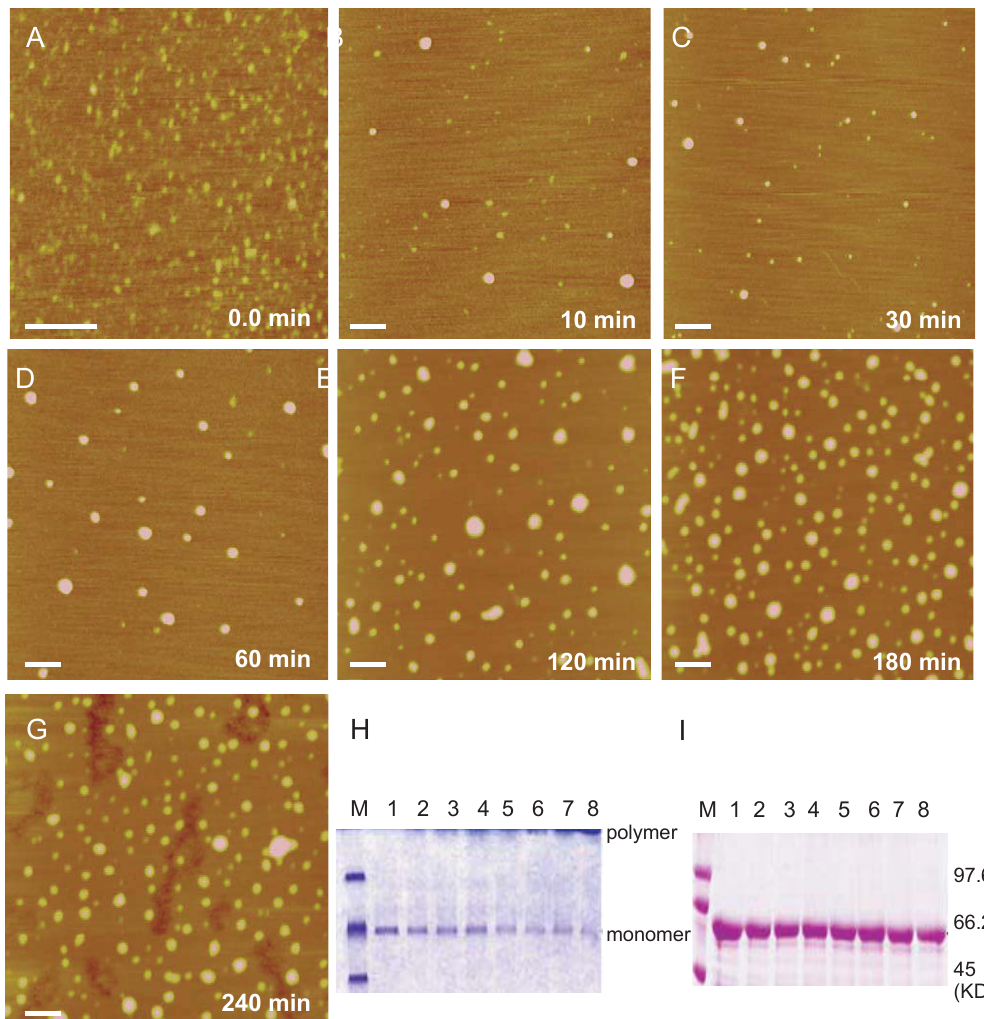
Figure 3. Kinetic aggregation of tau in formaldehyde solutions. Neuronal tau was added to the phosphate buffer (pH 7.2, 37 u C) containing 0.1% formaldehyde, and aliquots were taken for observation under the atomic force microscope at different time intervals as indicated in each images ( A– G ). The scale bars equal 100 nm. The parallel SDS-PAGE study ( H ) shows tau incubated with 0.1% formaldehyde for different time periods, with Lanes 1 to 8 representing 0, 30, 60, 90, 120, 150, 180 and 240 min, respectively. Lane M is the protein molecular mass marker. Acetaldehyde (0.1%) was used as a control and the result is shown in I .